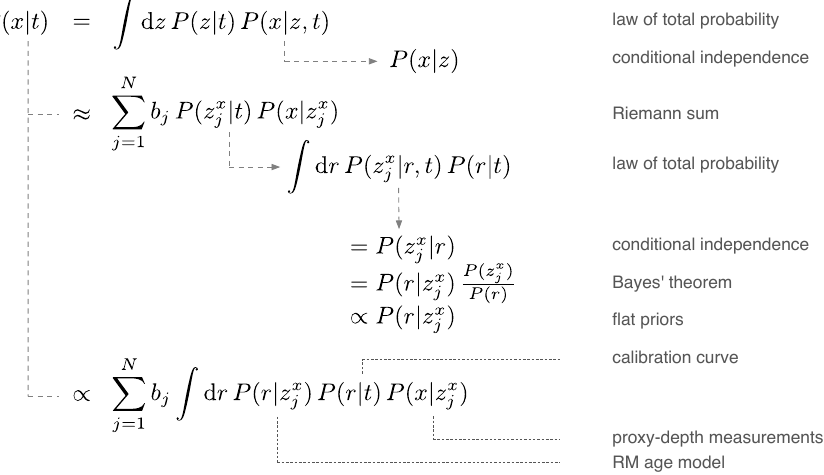
Figure 1. Outline of posterior proxy probability derivation. The box presents a rough sketch of the derivation of the posterior proxy proba- bility densities. We denote the proxy, depth, time and radiometric age with the random variables X , Z , T , and R , respectively. The essential quantity of interest to be estimated is the posterior conditional density P(x | t) , which is finally expressed in terms of the measured/given quantities using the above steps. For a detailed explanation, please refer to Sects. 2.3 and 2.4.